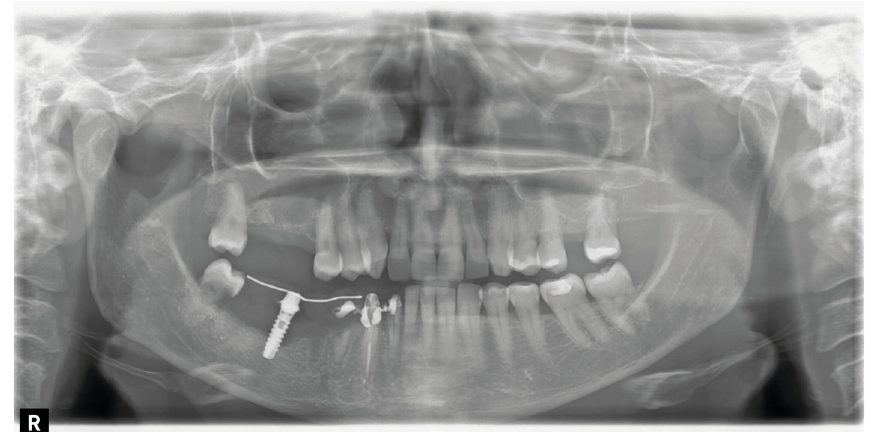
Figure 3: After extraction of compromised teeth, a provisional prosthesis was positioned.